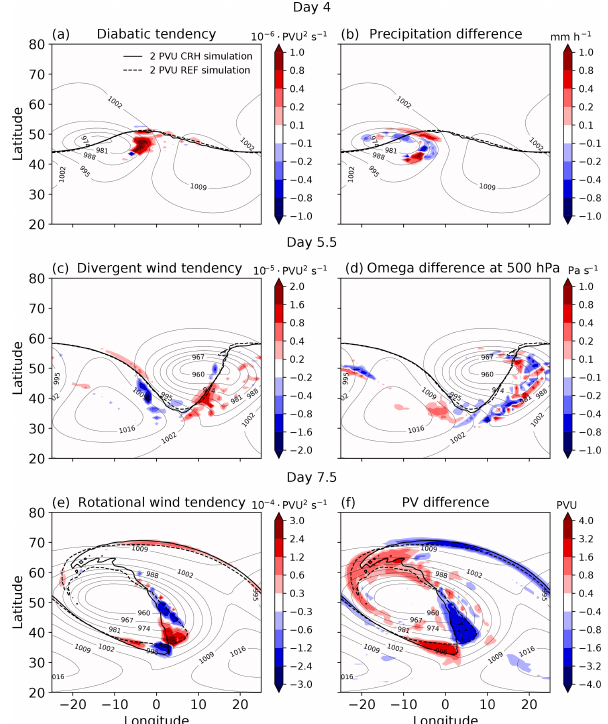
Figure 12. Illustration of the dominant contributions to the evolu- tion of difference potential enstrophy during different stages of the cyclone growth (a, c, e) . Panels (b) , (d) , (f) illustrate the underlying processes by means of fields that are closely related to the different contributions. Thick black contours show the dynamical tropopause for the REF (dashed) and CRH (solid) simulations. Thin contours show the surface pressure (hPa) averaged between the two simula- tions. The differences are calculated as